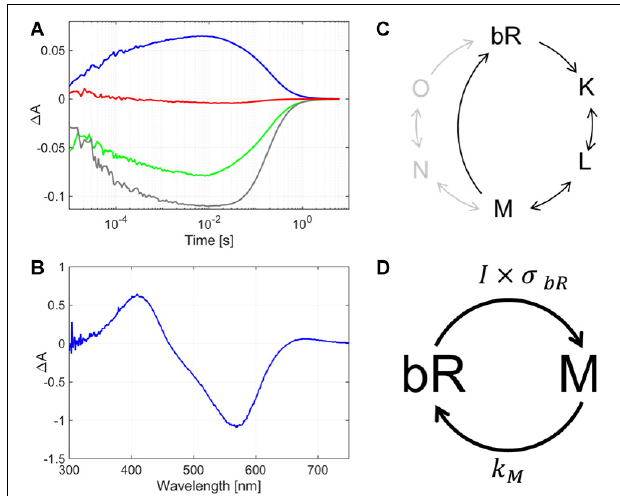
FIGURE 3 | (A) Absorption kinetics and (B) intermediate accumulation measurements taken on a glycerol-containing bR film. In panel (A) , the lines represent the change of absorption after light-excitation measured at 410 nm (blue line), 500 nm (green line), 575 nm (gray line) and at 620 nm (red line). In panel (B) , the difference absorption spectrum is shown, as measured after a 10-s excitation by subsequent laser pulses of a repetition rate of 2 Hz. (C) Schematic diagram of the full photocycle of a glycerol-containing bR film (black) and bR in water (gray). (D) Simplified diagram of the photocycle of the glycerol-containing bR film showing only the states relevant for our pulsed Z-scan measurements. I is the (average) light intensity exciting the sample, σ bR is the absorption cross section of the bR molecule in the initial state, at the wavelength of excitation, and k M is the rate constant of the